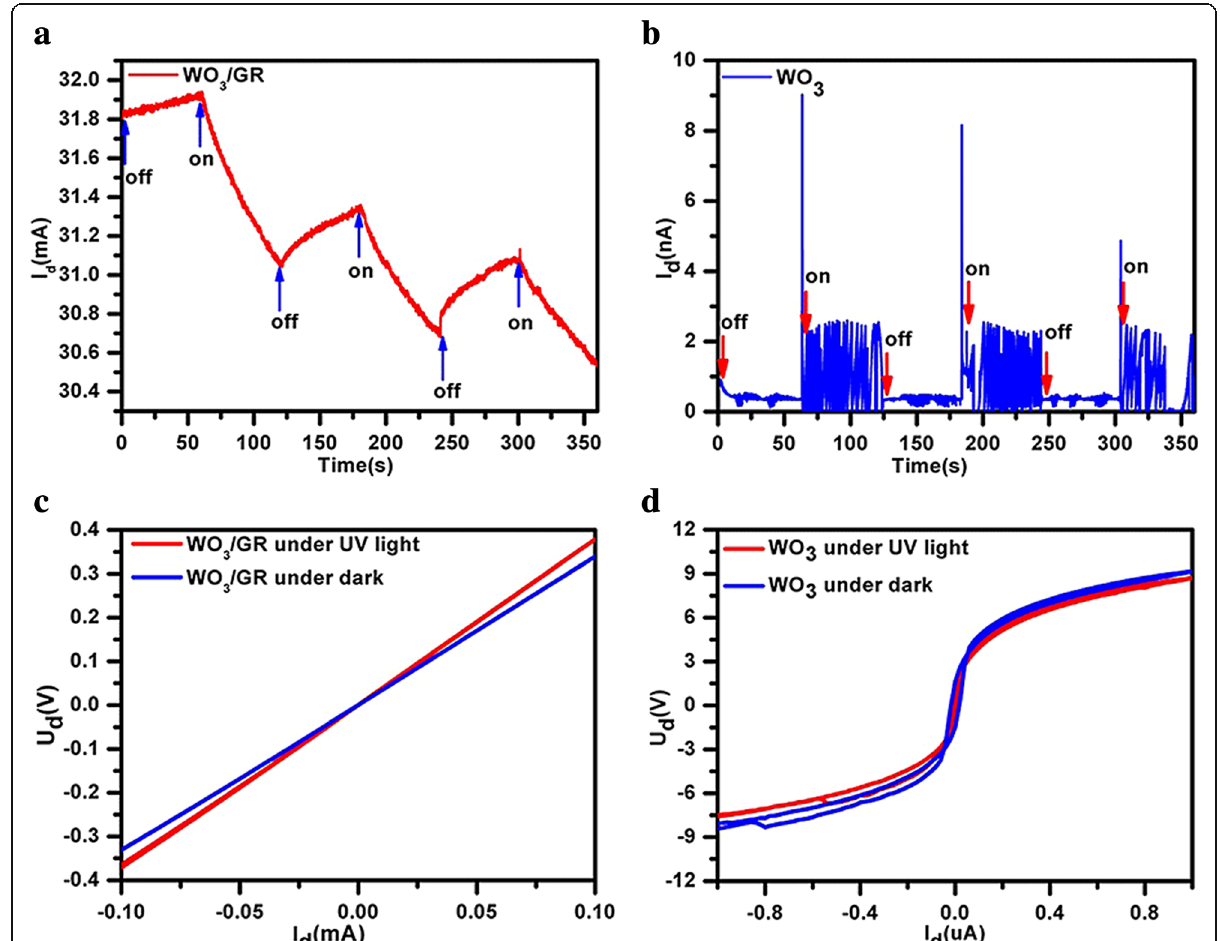
Fig. 5 Experimental observation of characteristics in WO 3 /GR device compared with the pure WO 3 device. a Photocurrent of WO 3 /GR. b Photocurrent of WO 3 . c Photoresistance of WO 3 /GR. d Photoresistance of WO